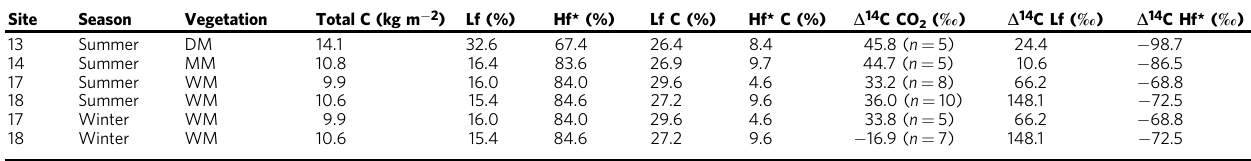
Table 2 Soil carbon pools at each sampling location and seasonal analysis of their respective radiocarbon signatures Site